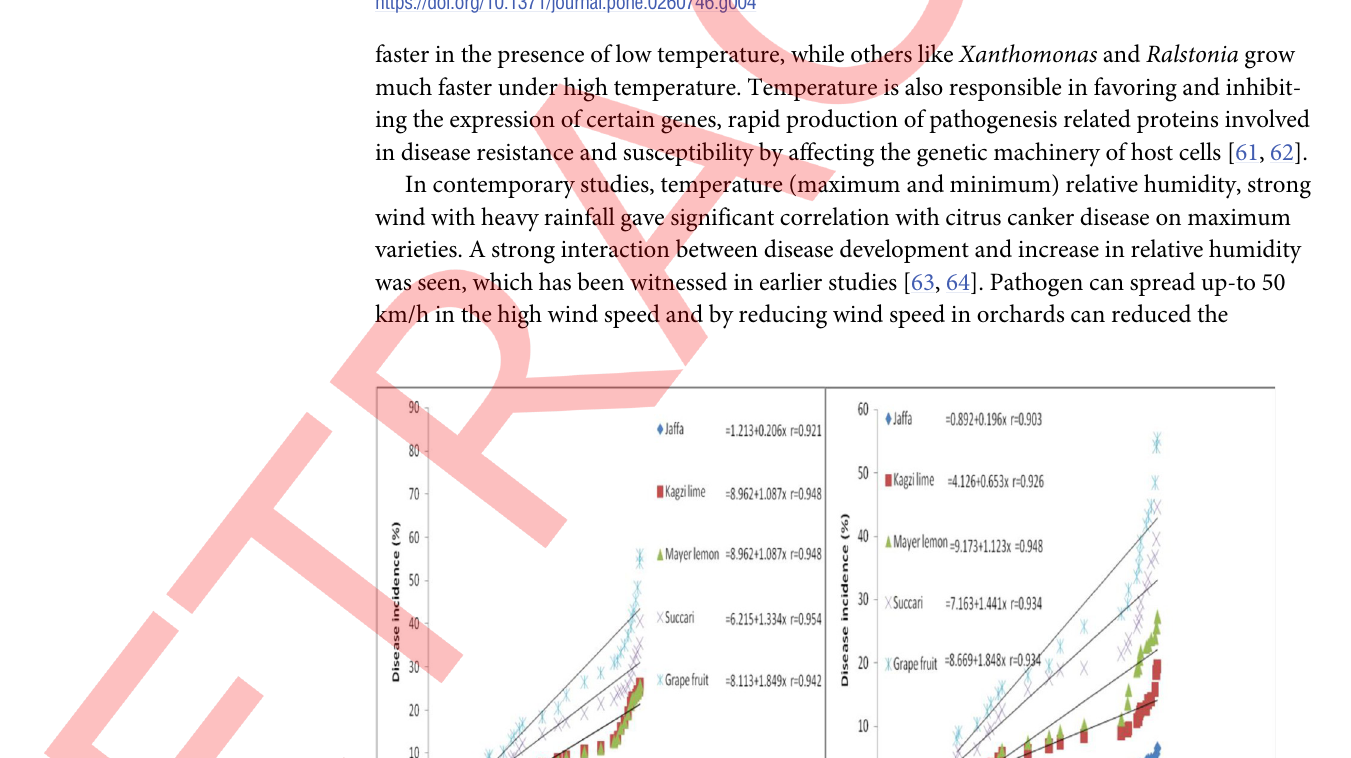
Fig 4. Relationship of maximum temperature with the development of citrus canker disease with during 2017–18 (A) and 2018–19 (B).